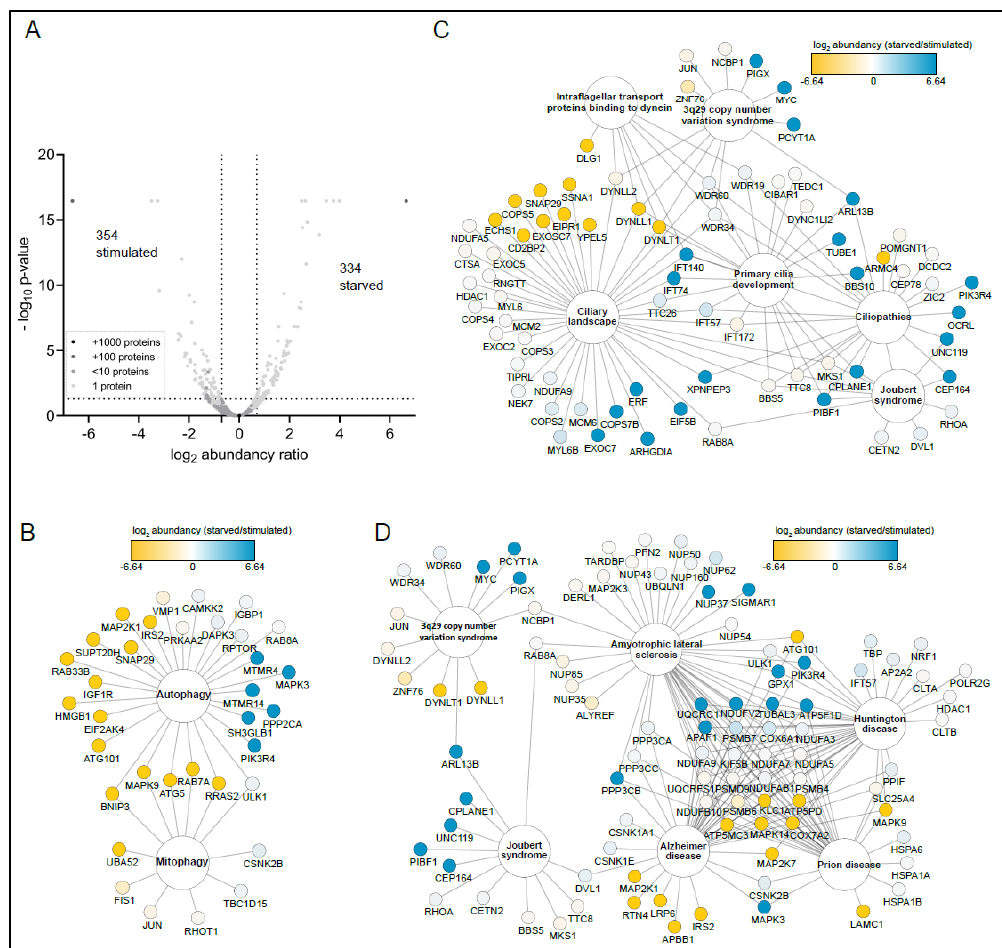
Figure 3. Interactome analysis revealed SZT2 interactors that preferentially bind upon starvation or stimulation. ( A ) Volcano plot of all identified proteins interacting with SZT2 with the abundancy ratio of interacting proteins upon starvation versus stimulation. The gray color scale depicts the number of proteins that have the same abundance and p -value. Proteins binding with a higher affinity to SZT2 upon starvation have a p -value below 0.05 and an abundance ratio of 1.5 over proteins binding upon stimulation (within right dotted lines). Map of ( B ) autophagy, ( C ) cilia-associated and ( D ) neurological disorder-associated terms, depicting identified proteins found in the SZT2 interactome. The color code shows the log2-abundance ratio of the single proteins with proteins binding SZT2 upon starvation colored in blue and upon stimulation colored in yellow.